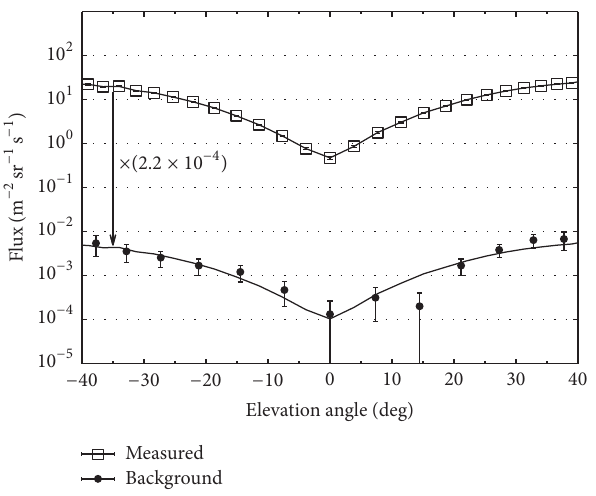
Figure 14: The measured background flux 𝑓 (oscillator) trigger, compared with the true particle flux 𝑓 (with normal triggering conditions). There is nearly four orders of magni- tude difference between the two curves, which have similar shapes (indicated with the line), including a clear minimum at the horizon.